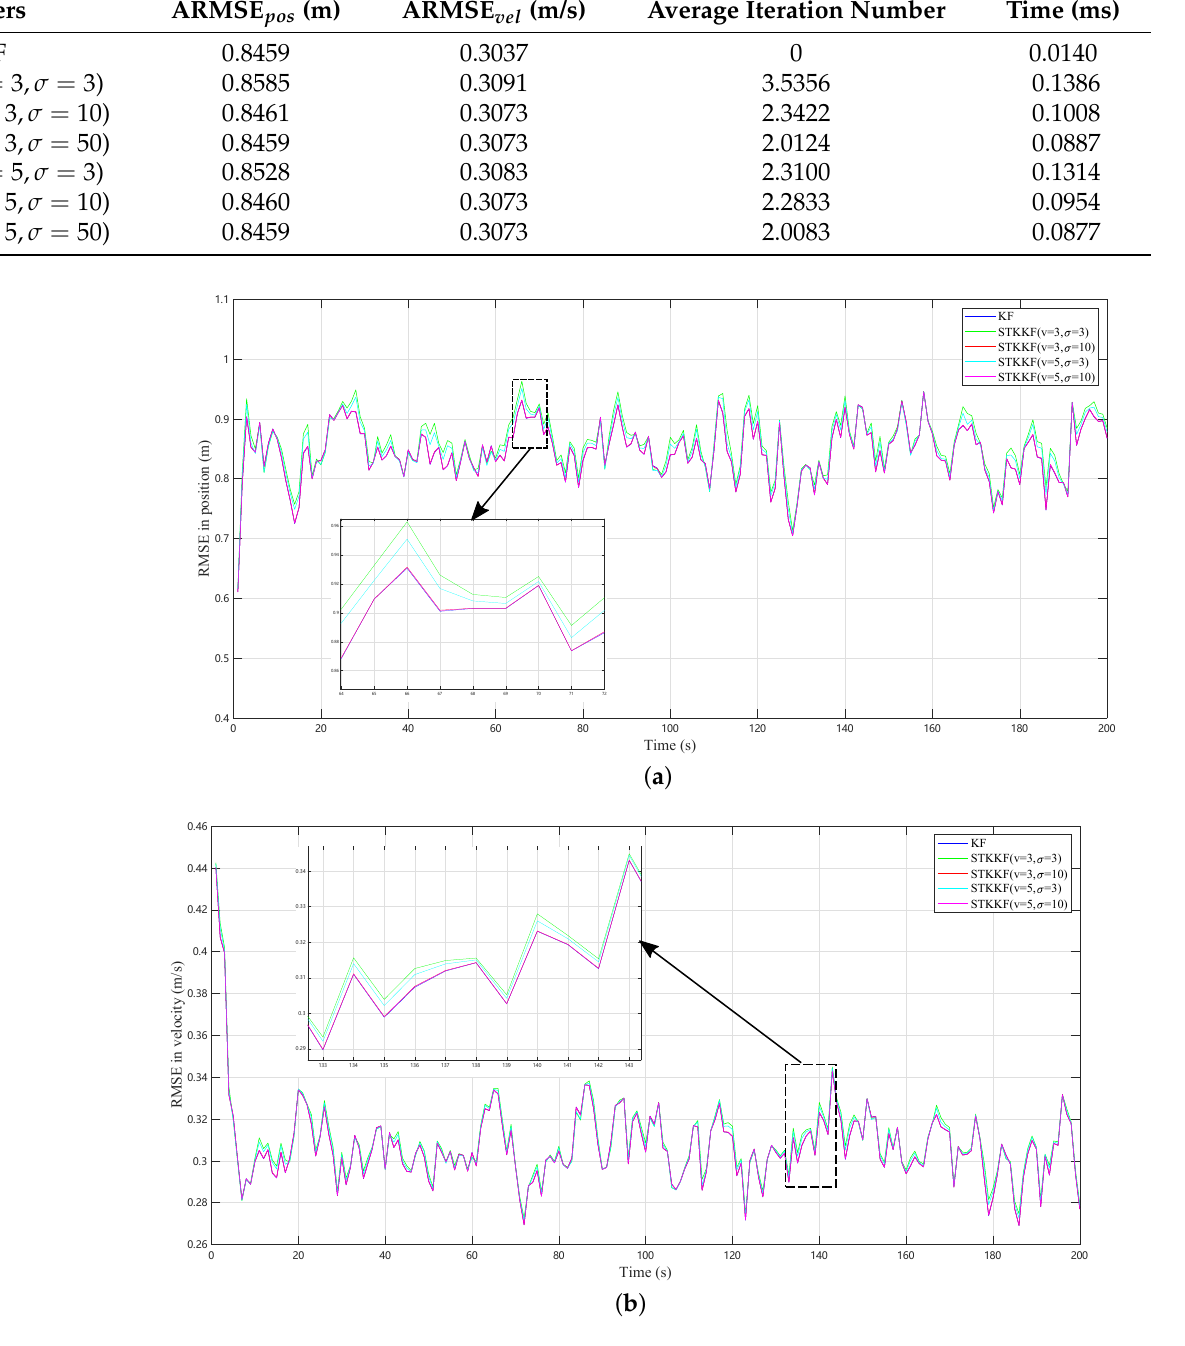
Figure 1. RMSE results of KF and STKKF in case 1 where RMSE is taken over 100 Monte Carlo simulations: ( a ) position. ( b )